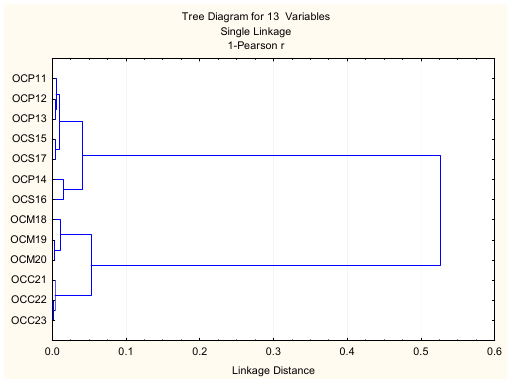
Figure 3. Bidimensional dendrogram representing the similarity in the main components of the essential oils, between 13 harvests of 4 basil varieties growing in the field conditions.